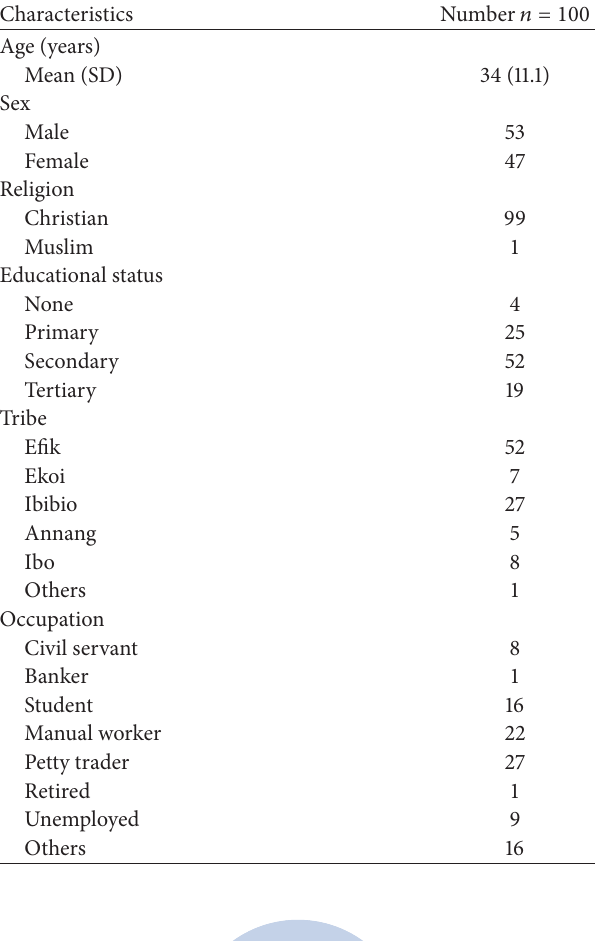
Table 1: Demographics of subjects.